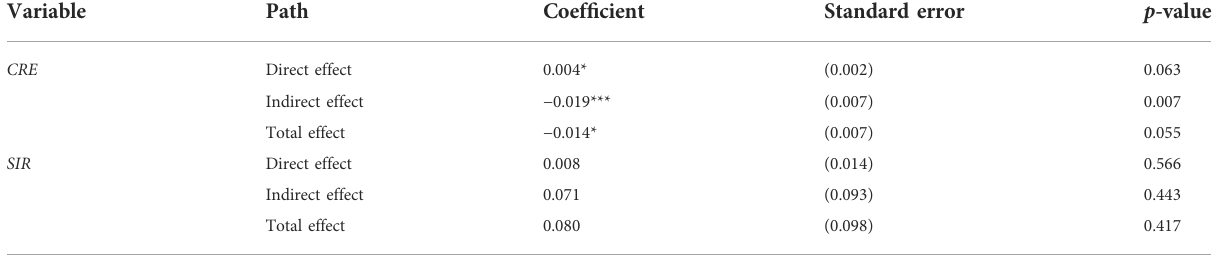
TABLE 5 Decomposition results of spillover effects of the spatial Durbin model.